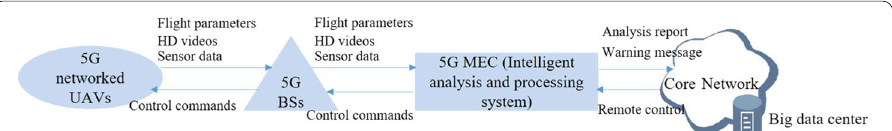
Fig. 1 The scenarios of 5G-enabled IoTs with UAVs-aided